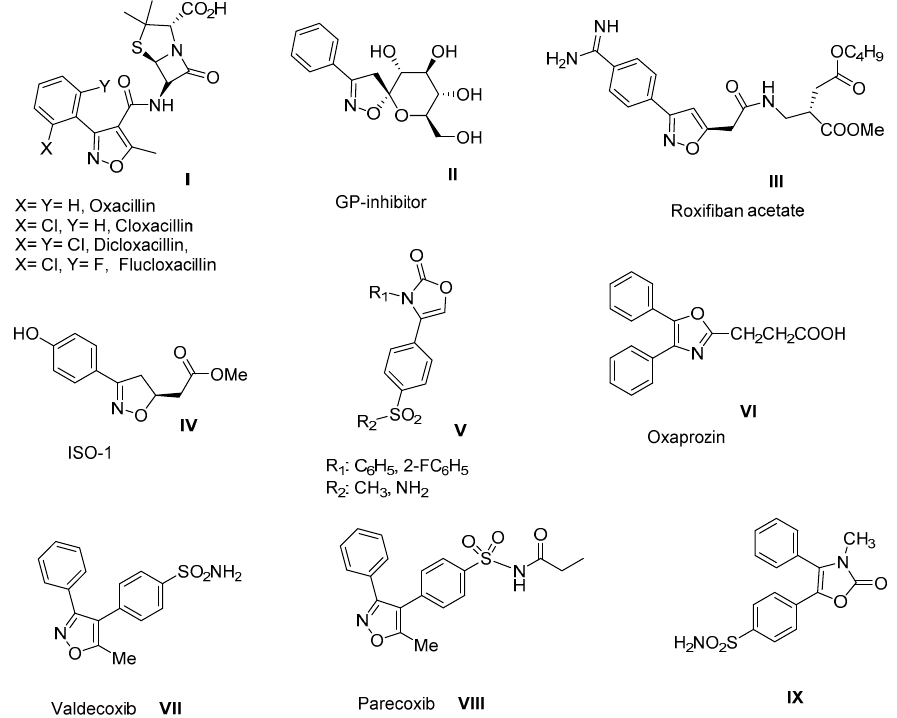
Figure 1. Representative biologically active oxazole-derivatives .